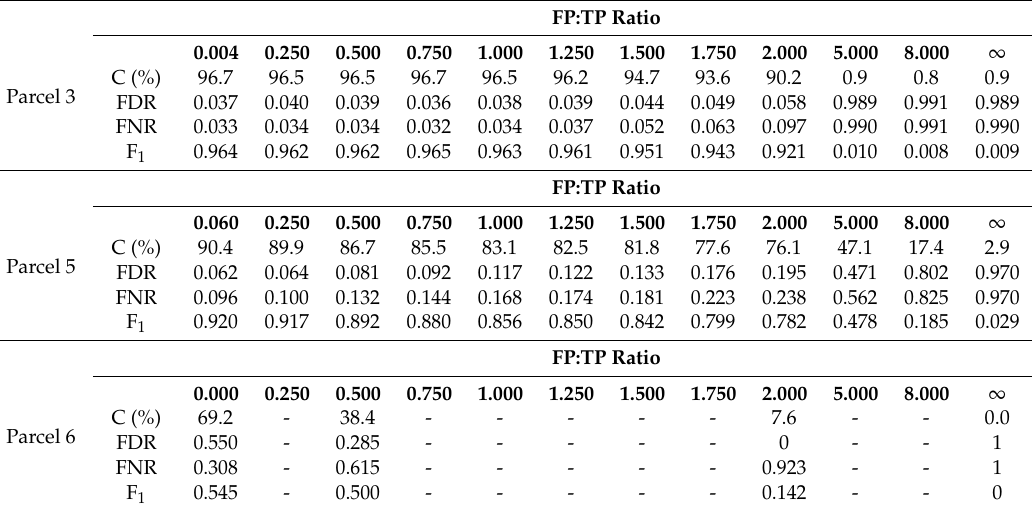
Table 9. Data quality measures results for different FP:TP ratio thresholds in parcels 3, 5, and 6 (the highlighted column in gray indicates the respective values for